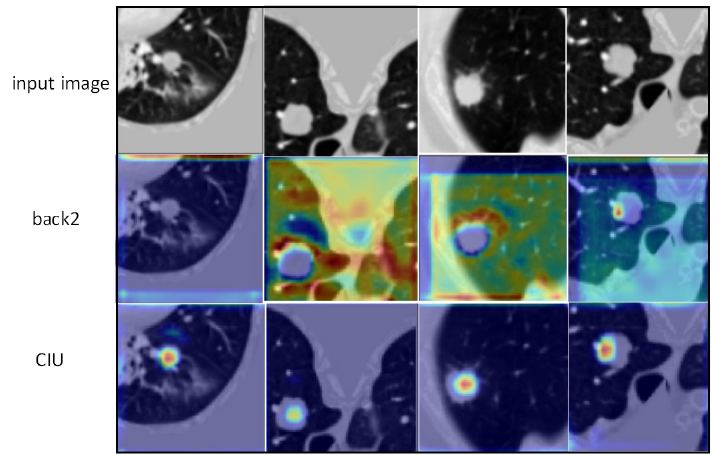
Figure 8. Grad-CAM visualization results. The first row represents the input images, the second row denotes the output heatmaps of back2, and the third row represents the output heatmaps of the